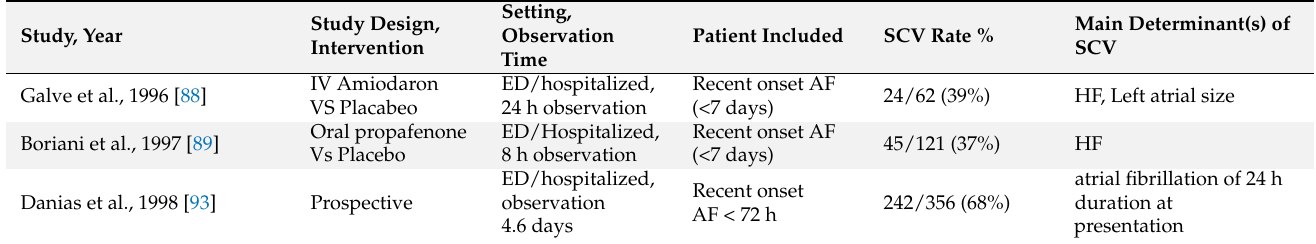
Table 1. Studies evaluating the rate and determinants of spontaneous cardioversion of atrial